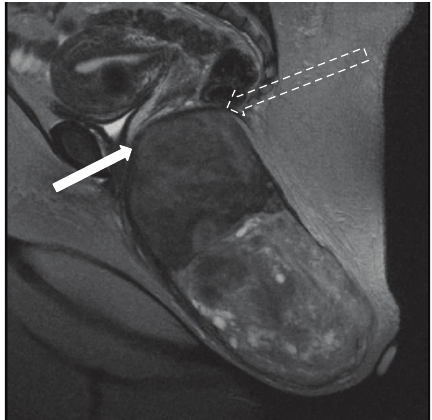
Figure 2: MRI sagittal plane. 23 cm (craniocaudal) mass exhibits midrange T2 weighted signal superiorly with diminished T2 weighted signal at its inferior position. White arrow showing the mass abutting the posterior wall of the vagina. Dashed arrow showing the rectum wall.